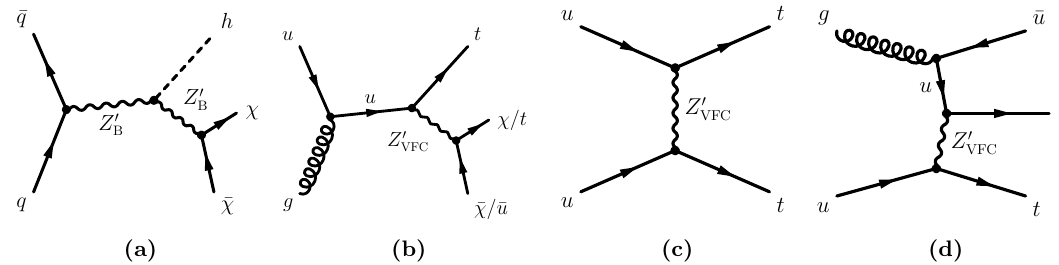
Figure 2. Schematic representation of the dominant production and decay modes for the (a) VBC model and (b,c,d) VFC